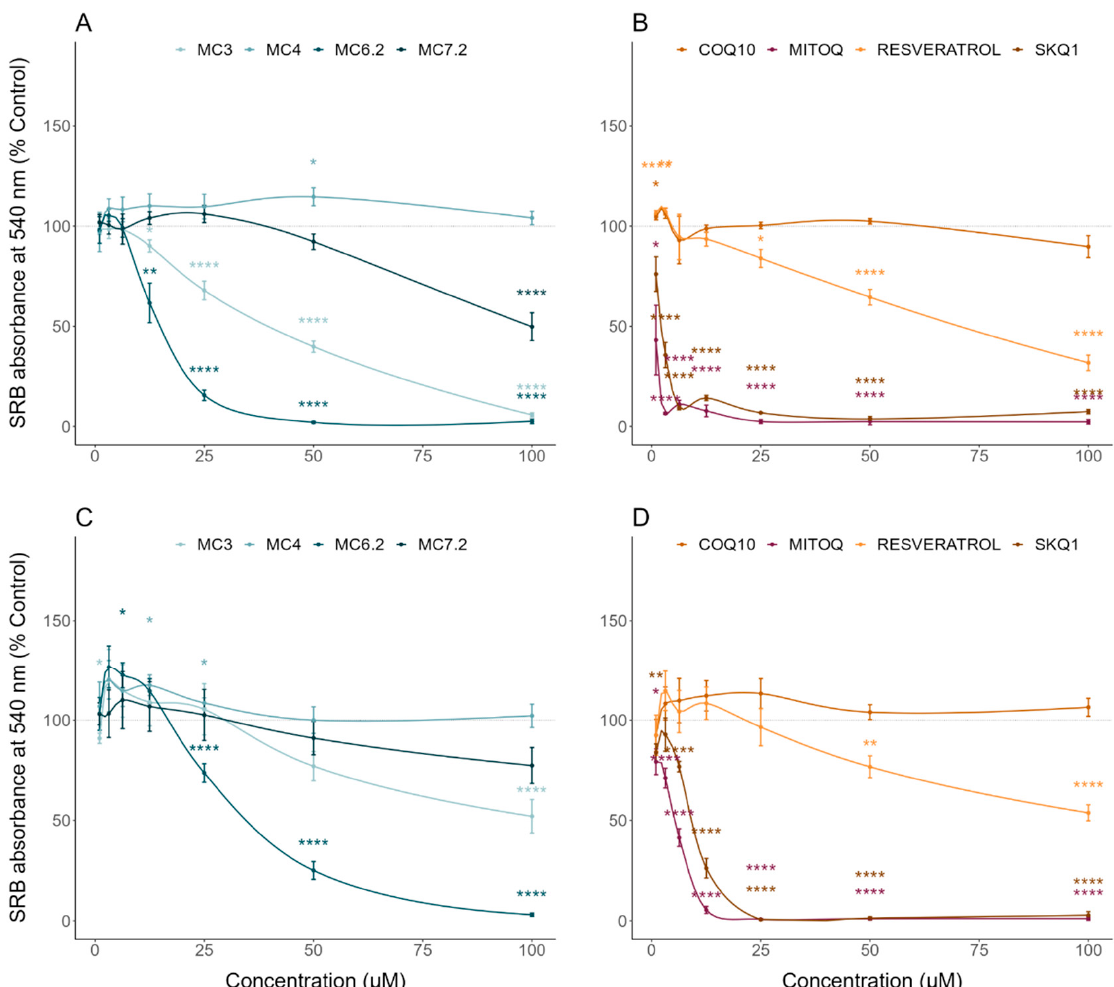
Figure 2. Effect of MitoCINs, quinone-based mitochondria-targeted and non-targeted antioxidants on cell mass. Human Caucasian hepatocyte carcinoma (HepG2, ( A , B )) and differentiated human neuroblastoma (SH-SY5Y, ( C , D )) were treated with increasing concentrations of the different molecules for a period of 48 h and cellular mass was evaluated using Sulforhodamine B (SRB) assay. Data are the mean ± SE of four independent experiments and the results are expressed as a percentage of the control. Statistically significant differences between control (CTL) and treated groups were evaluated as described in the Materials and Methods section. **** p < 0.0001, ** p < 0.01 and * p < 0.05 compared to the respective control (CTL).